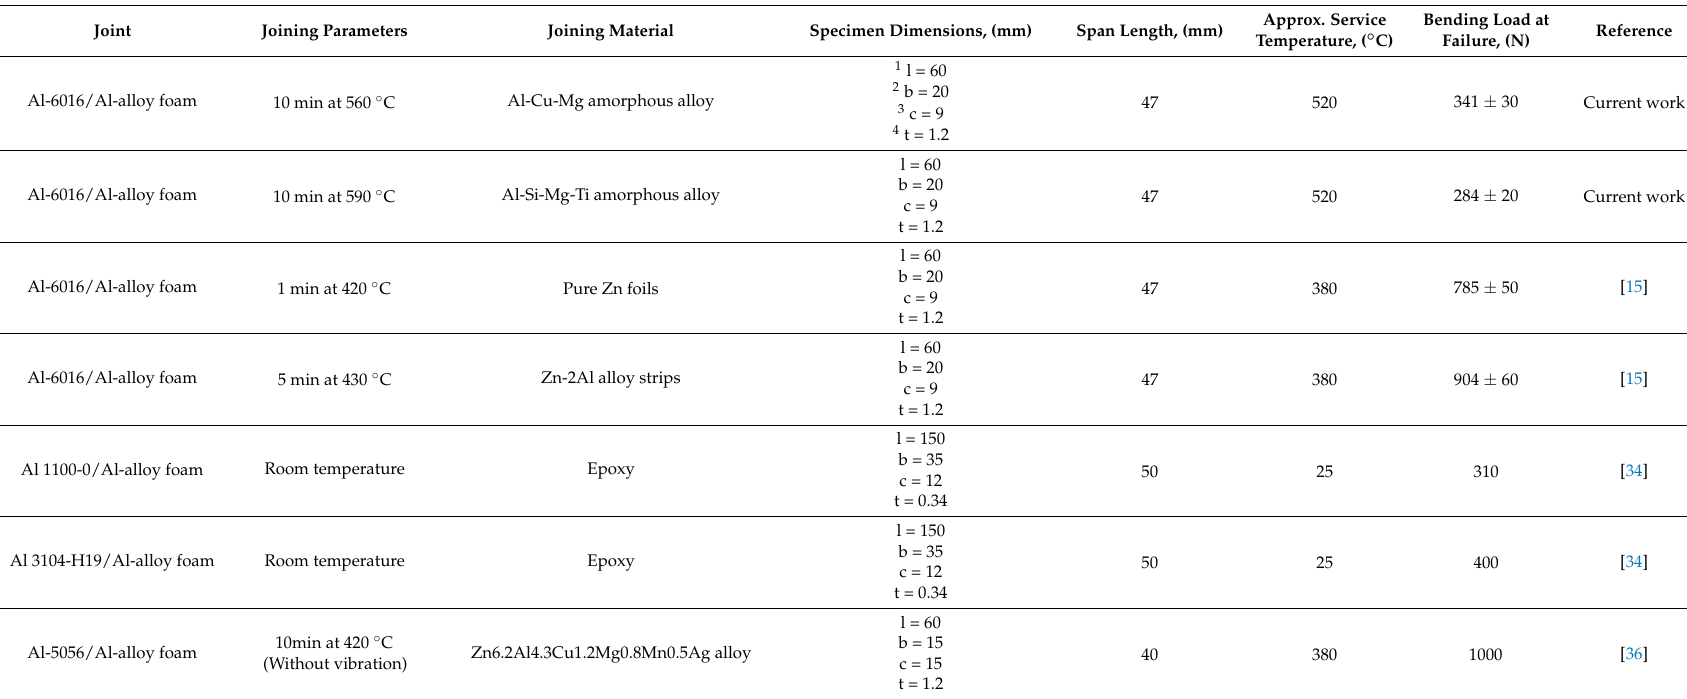
Table 1. Average three-point bending test results for obtained and similar AFS components reported in the